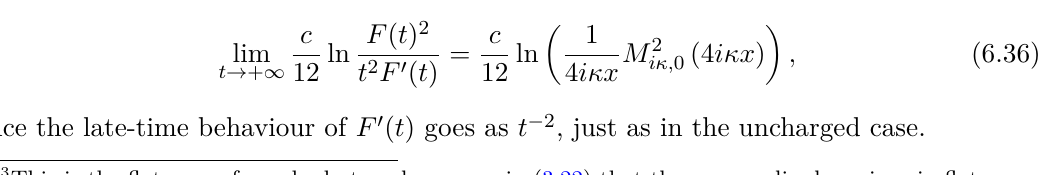
= Q 2 0 , x = 1 for which there is no 0 2 K